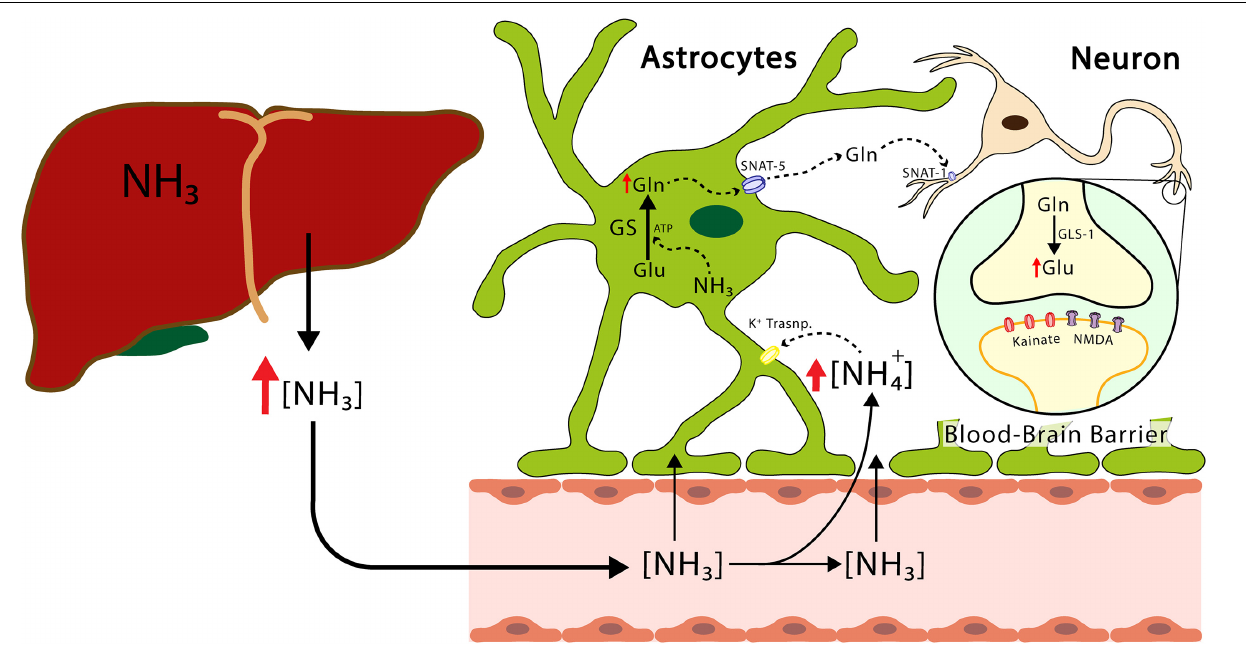
FIGURE 2 | The transport of ammonium from the liver to the CNS. The ammonium leaves the liver and reaches the CNS, crosses the blood-brain barrier, reaches the astrocytes, and produces the release of proinflammatory factors and glutamine. The latter enters the neuron and increases the concentration of glutamate. Excess hyperammonemia and glutamate will be triggers of neuronal damage. GS, glutamine synthetase; GLS-1, phosphate-activated glutaminase; Glu, glutamate; Gln, glutamine; NH 3 , ammonia; NH 4 + , ammonium ion; NMDA, N-Metil-D Aspartate receptor; SNAT-1, astrocytic glutamine transporter-1.